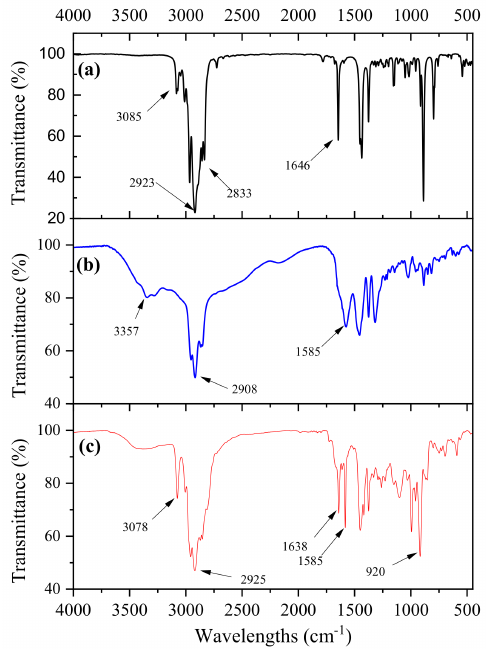
Figure 1. Comparison of the FTIR spectra of: ( a ) pristine limonene, ( b ) intermediate LC compound and ( c ) curing agent LCA. All samples were run as films on a KBr disc.